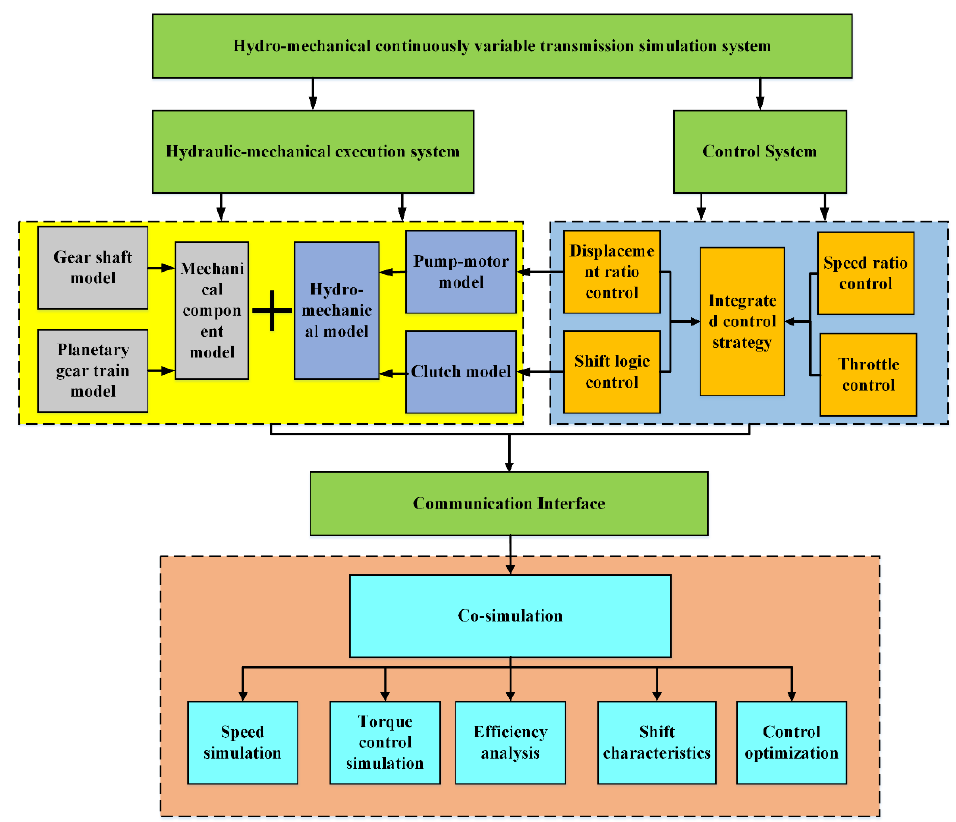
8 of 23 Figure 3. Dynamic model of HMCVT shafting (i1, i2, i3, …i11 represent different gear pairs; P rep- resents the variable pump; M represents the fixed motor). 2.4. The Composition of the Control System